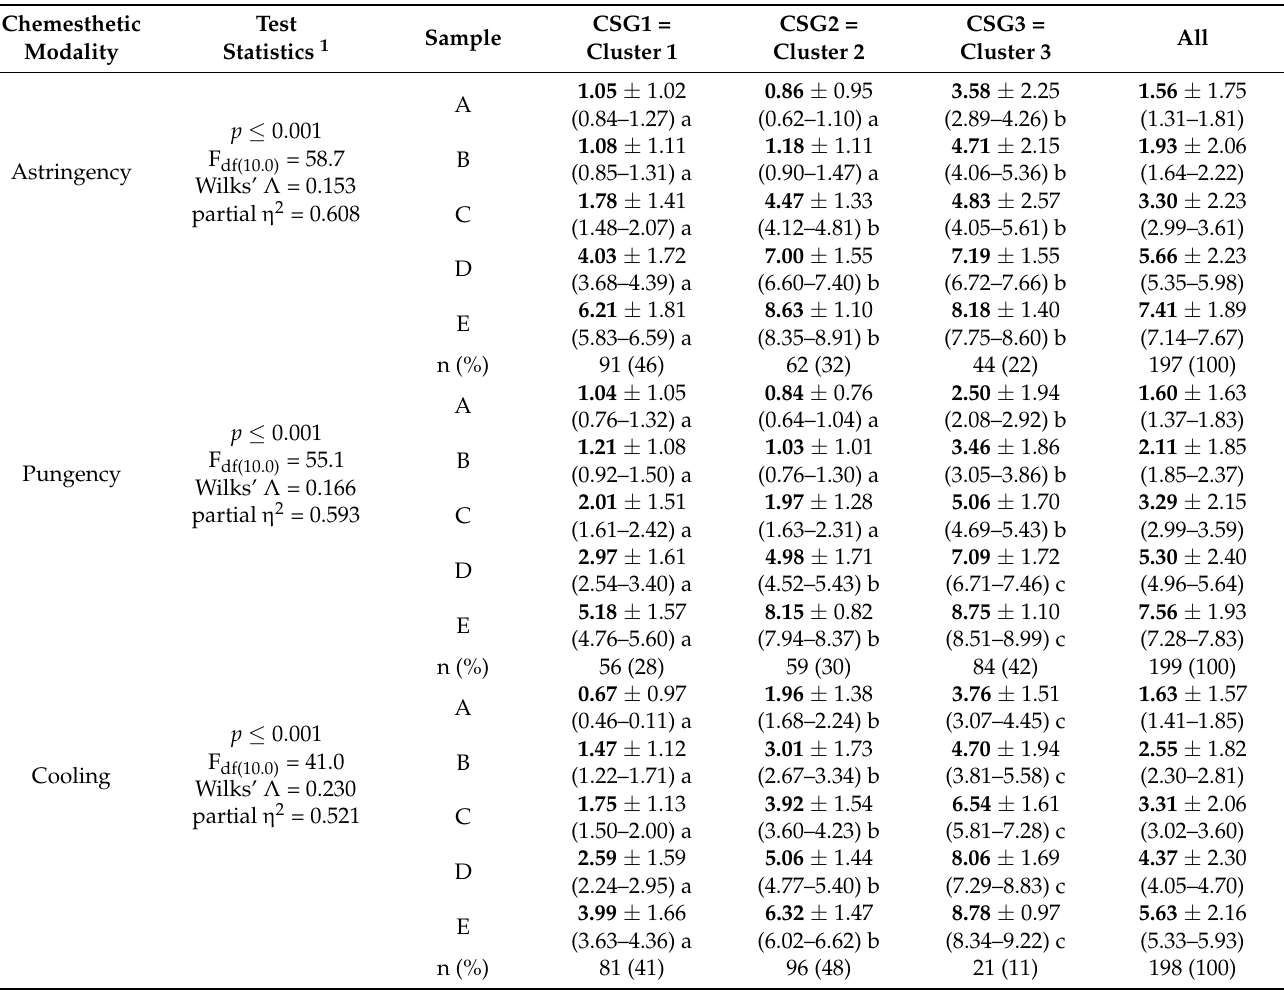
Table 3. One-way MANOVA-test results between clusters and chemesthetic sample series mean ± standard deviations (95% confidence intervals for the mean intensities in the brackets) for every sample (A–E, Table 1), and the distribution of subjects between the oral chemesthesis sensitivity clusters (CSG1, CSG2, and